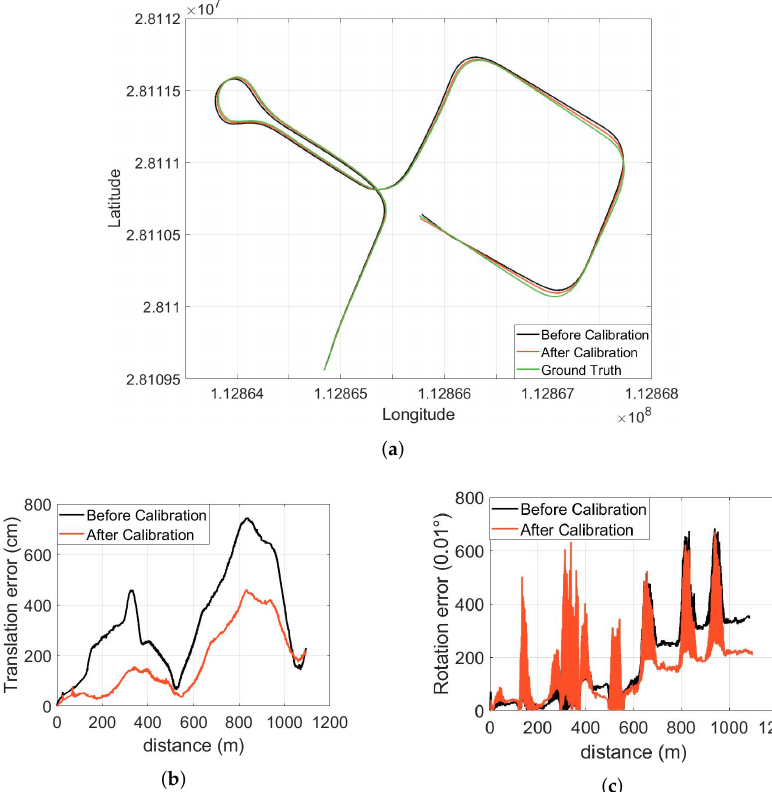
Figure 9. The localization results before and after hand–eye calibration, where ( a ) compares the trajectories before/after hand–eye calibration with the ground truth; ( b ) compares the translation error before/after calibration, and rotation error is shown in ( c ). In this experiment, the UGV drives at a speed around 25 km/h, and the overall distance is about 1.1